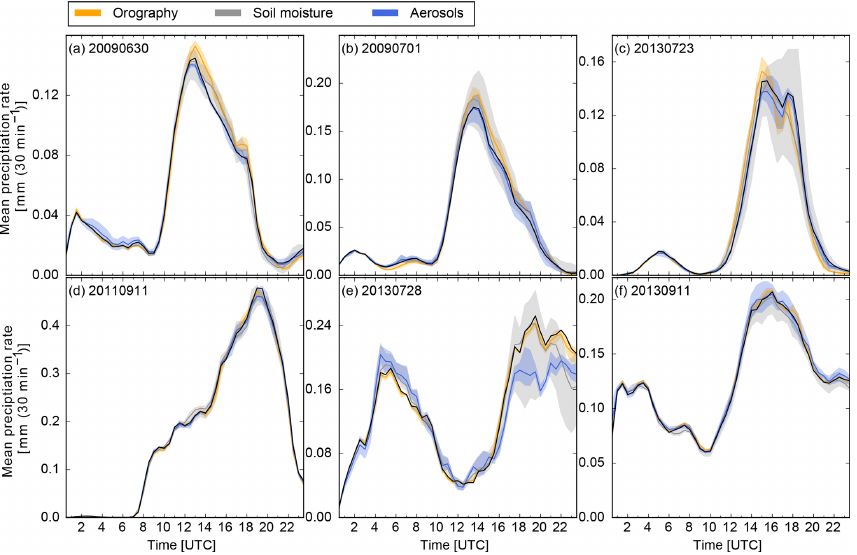
Figure 5. Domain-averaged precipitation rates for the 6 days of investigation. The color-coded areas represent the spread, i.e., the maximum and minimum mean precipitation for each set of sensitivities.